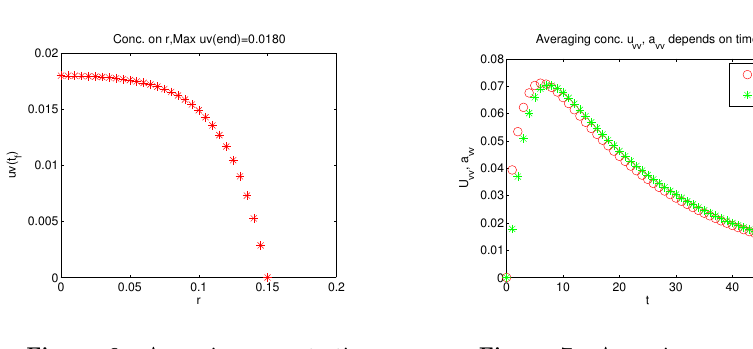
Figure 4. Concentration u ( r,z,t f ) profile depending on r for t f = 50